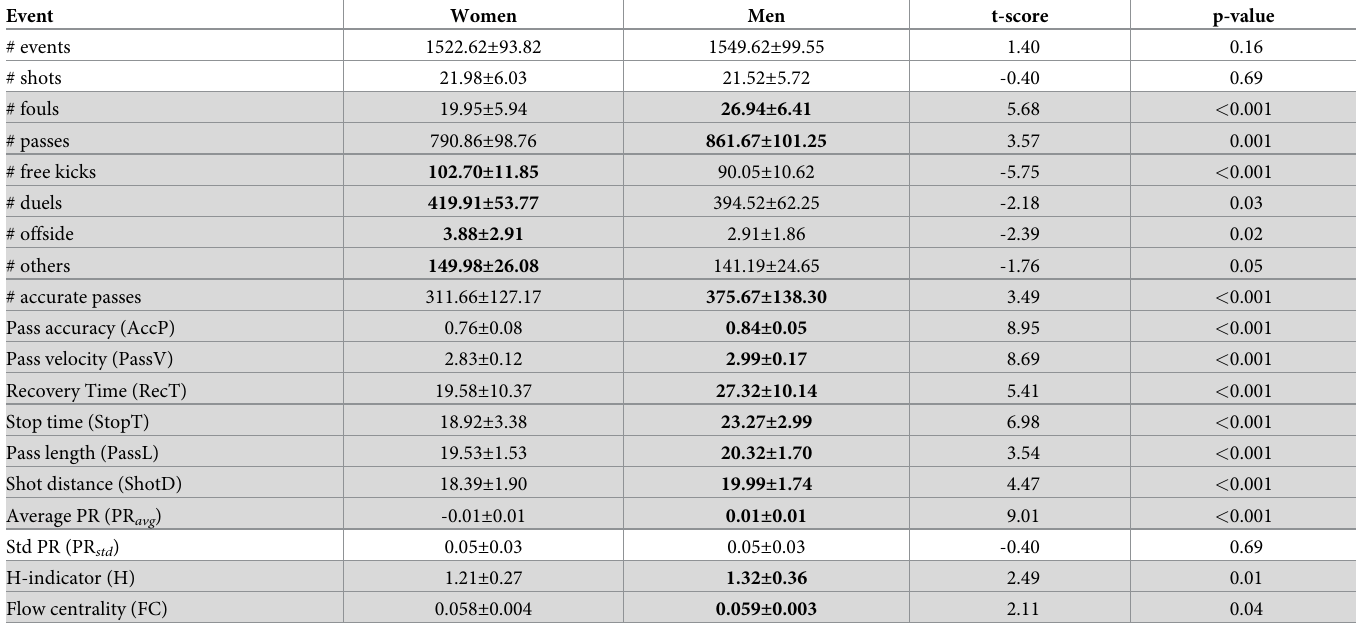
Table 2. Statistical difference of technical features between male and female teams. The summary data for both women and men are report as mean ± standard deviation per matches. Grey rows indicates features for which the difference between men and women is statistically significant. The highest values are highlighted in bold.